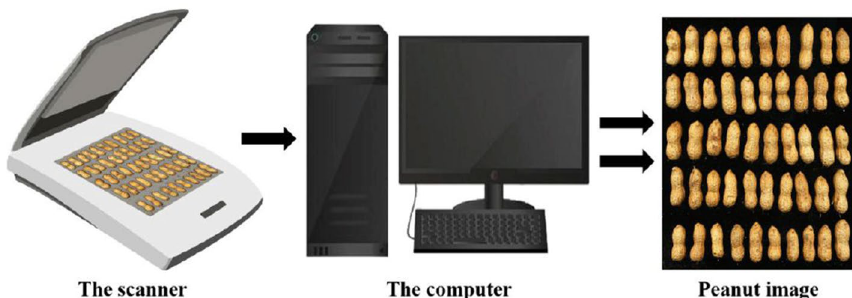
Figure 1. The workflow of peanut image collection.